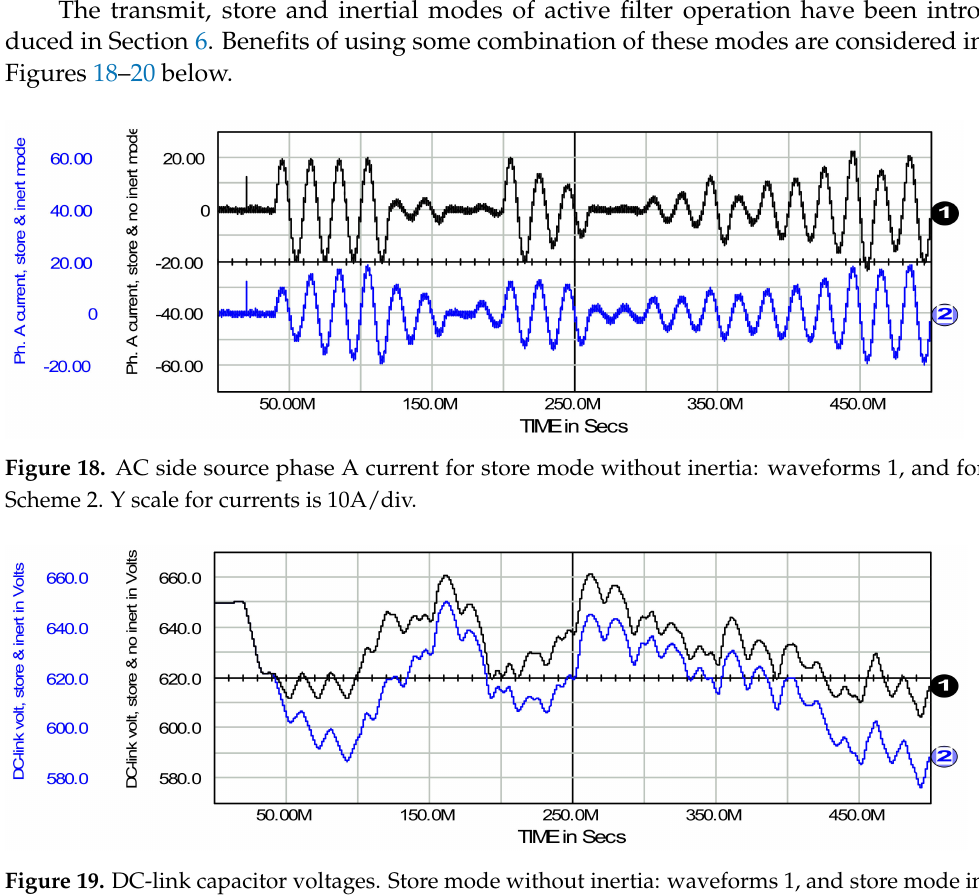
Figure 19. DC-link capacitor voltages. Store mode without inertia: waveforms 1, and store mode in combination with inertia: waveforms